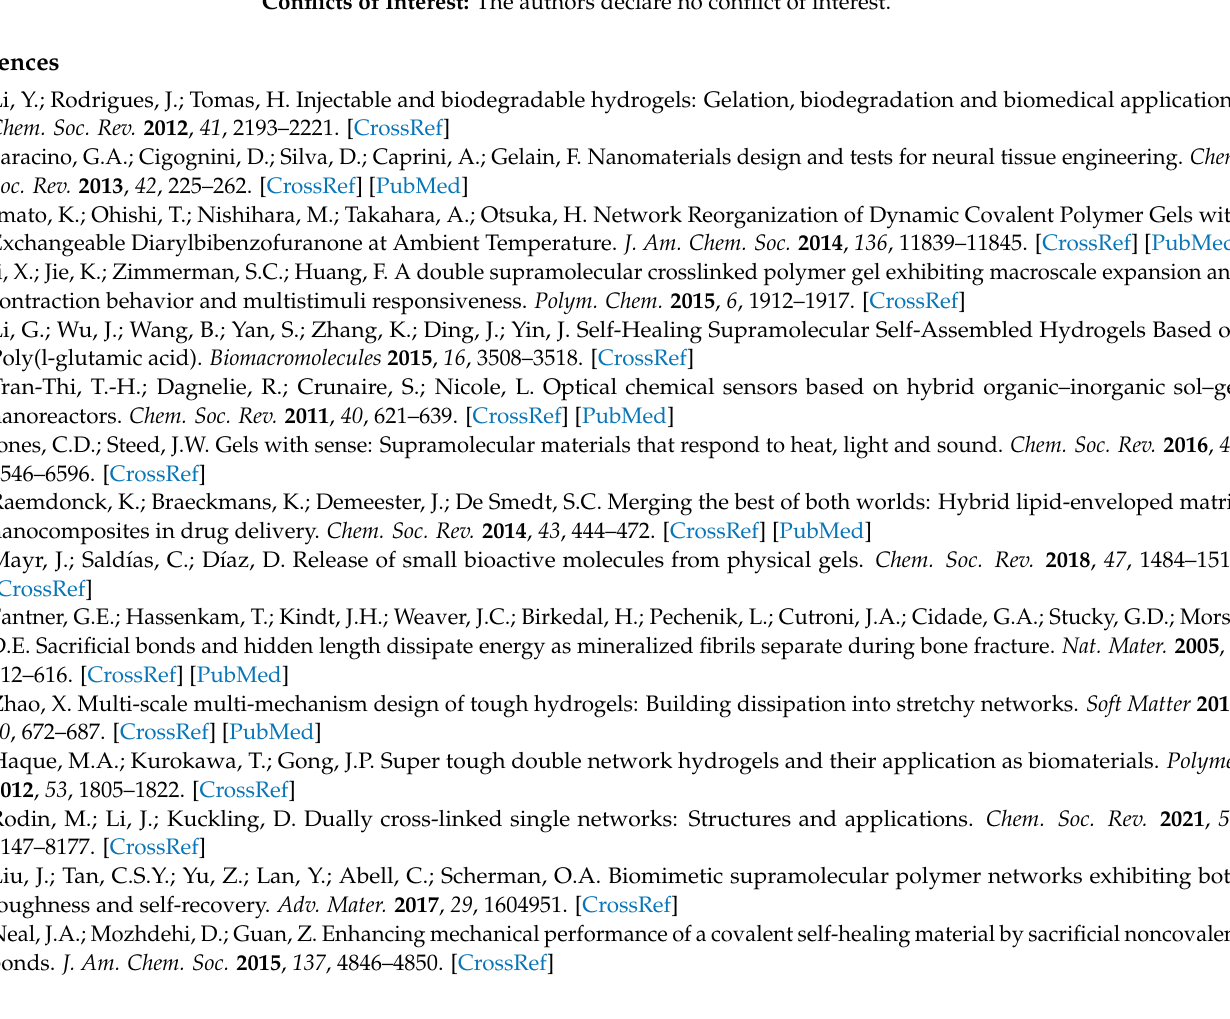
guest 2 . Figure S14: HR-ESI + -MS spectra of guest 2 . Figure S15: ATR-FTIR spectra of polymer gels G-HG . Table S1: The Q m values of the two samples of each gel. Movie S1; Movie S2; Movie